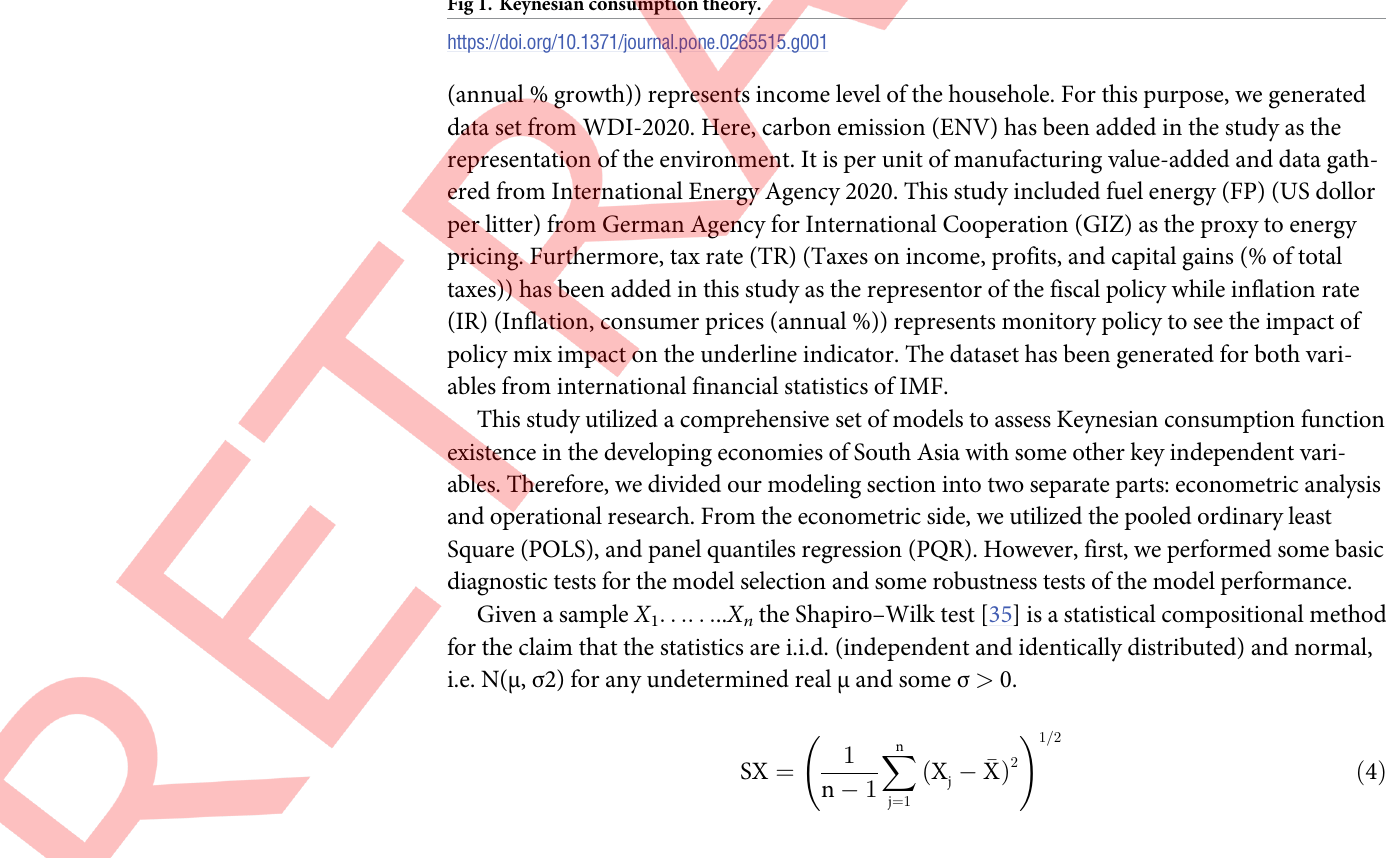
Fig 1. Keynesian consumption